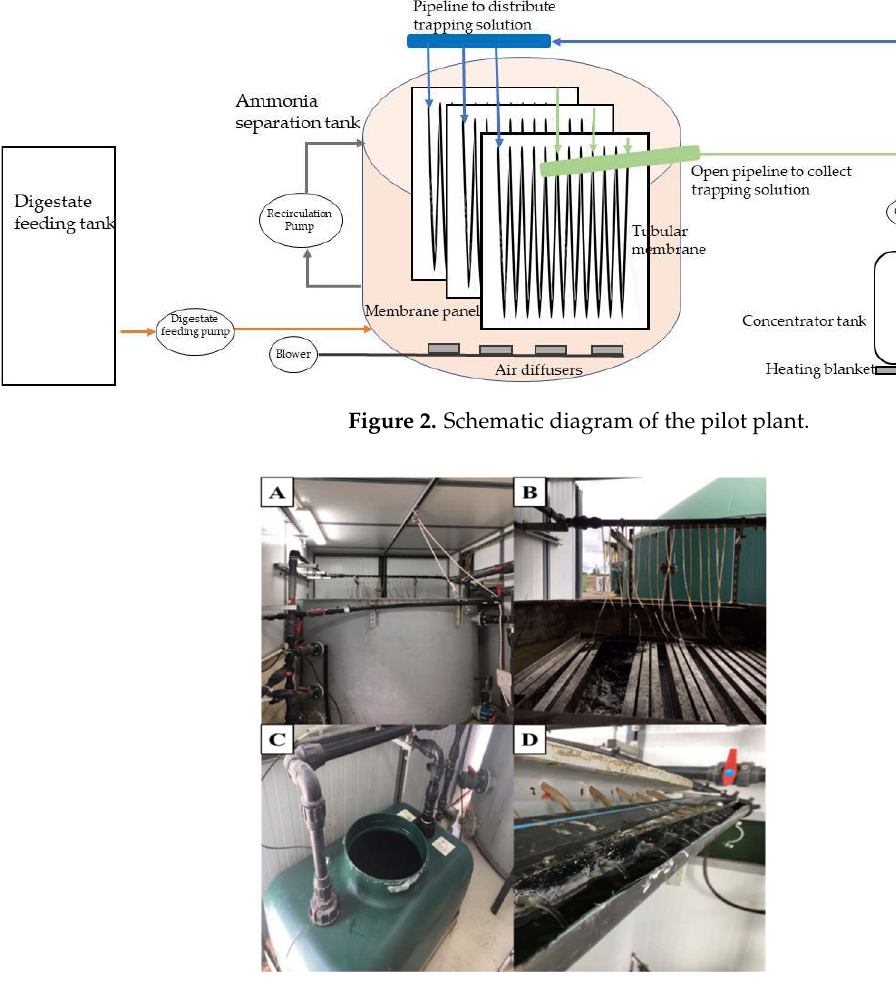
Figure 3. Pictures of the pilot plant located in the agro-industrial biogas plant. Ammonia separation reactor tank with a module of 16 parallel membrane panels ( A , B ), trapping solution tank ( C ) and open pipeline to collect the trapping solution at the exit opening of the membranes ( D ).